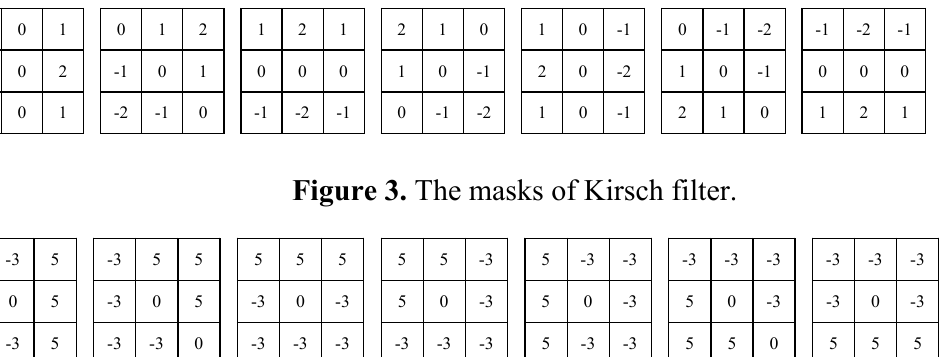
Figure 2. The masks of Robinson filter.